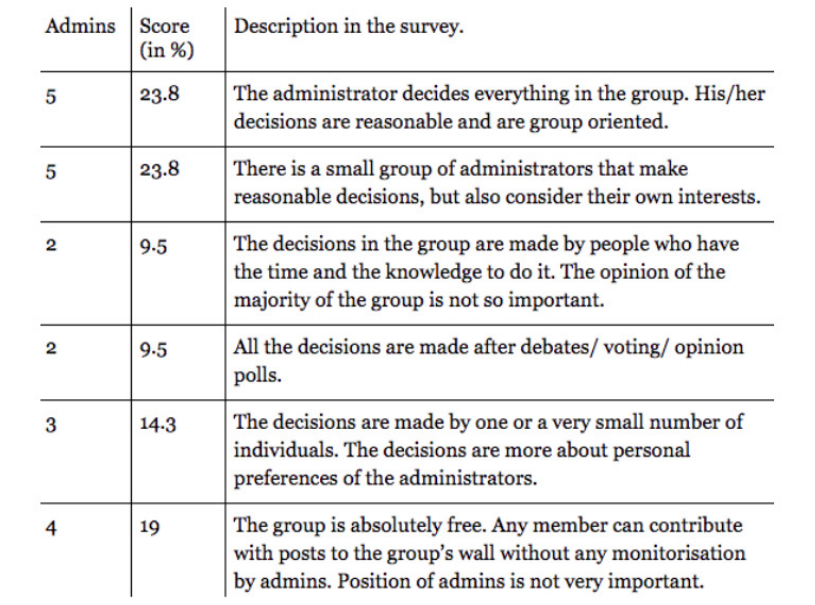
Figure 3. Most of the participants described their groups as top-down hierarchical